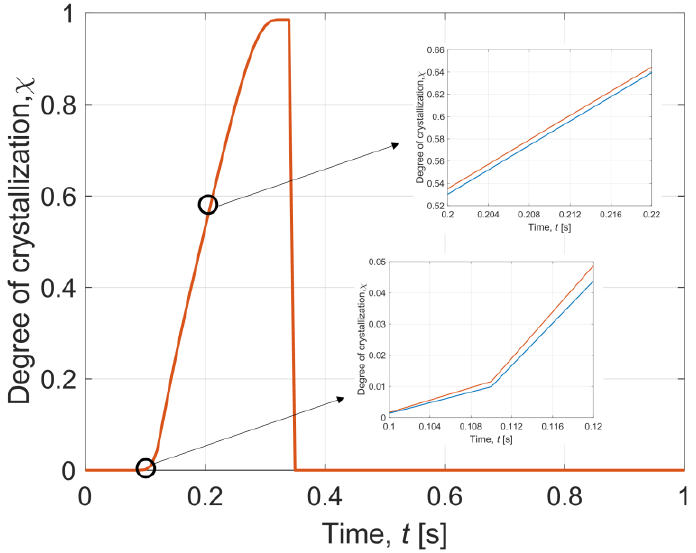
Figure 9. History of interval degree of crystallisation during warming in time 0 −1 s.